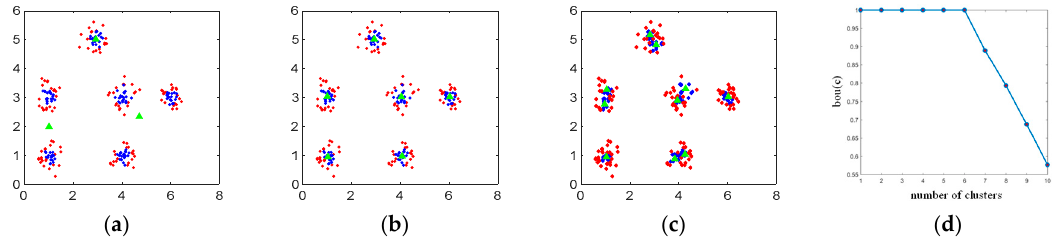
Figure 6. ( a – c ) shows the determined boundary points by using C-means and (10) when c = 3, 6, and 10, respectively. Blue and red points refer to the interior and boundary points, respectively; ( d ) shows the curve of bou ( c ) calculated according to (11); the sign Δ means the center of C-means. The red boundary points at c = 3 and 6 are similar to these in X , but these boundary points at c equals 10 are different from those in X . Figure 6d shows that the values of bou (c) are nearly